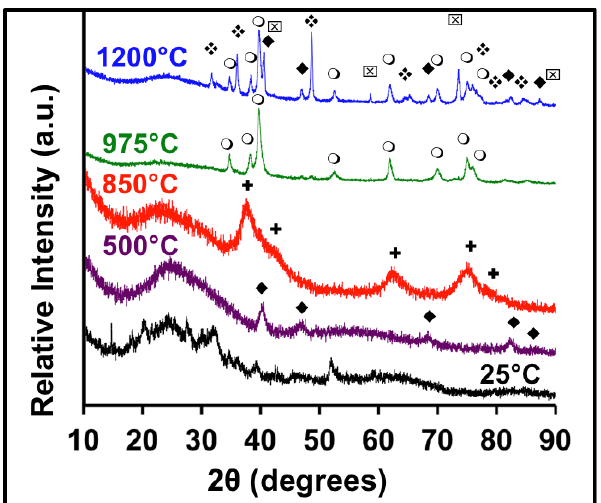
hex 00-025-1047).